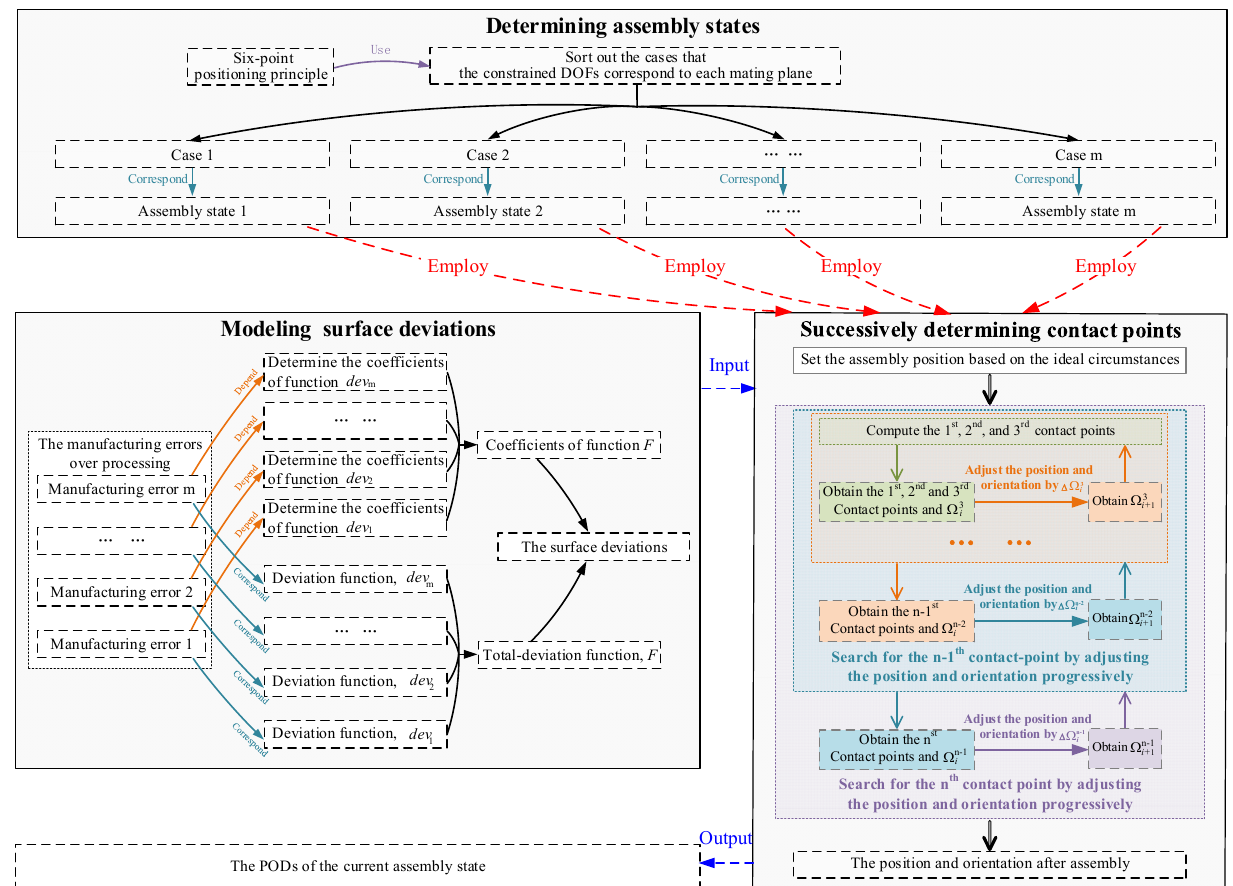
Figure 3. Framework of computing position and orientation deviations by successively determin ‐ ing contact points. DOF, degree of freedom.